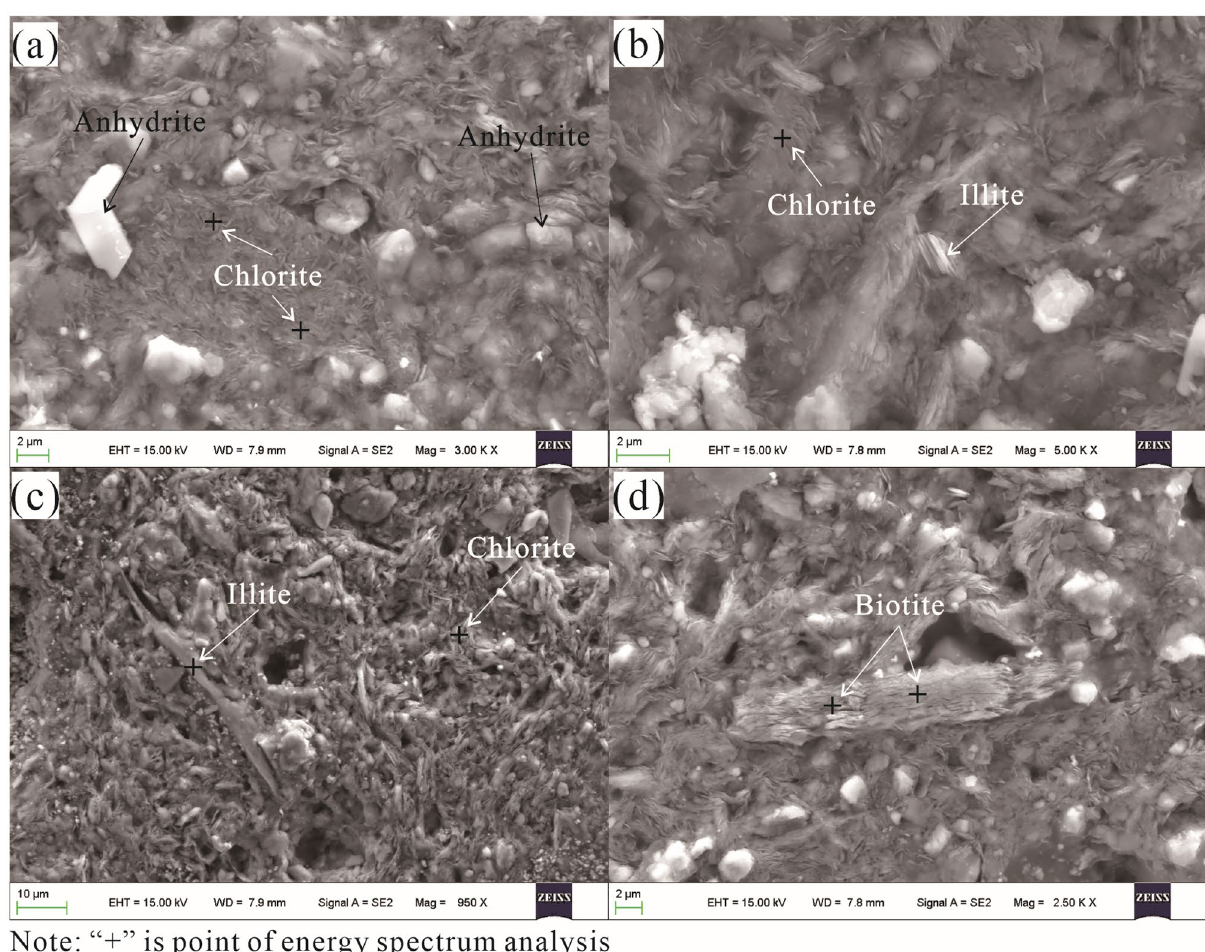
Figure 4. SEM images showing textural features of clay minerals. ( a ) Dominant chlorite and ( b ) flaky petaloid textures, ( c ) illite size and crystal structure and ( d ) close-up of biotite displaying the crystal size and relatively flat PAAS-normalized curve while that for granite was above that for the PAAS (indicating a higher content of REEs than that of PAAS) and with an apparent negative Eu anomaly; and (4) the pattern of the sample was also different from those of Jingdong and Mojiang basalts, whose PAAS-normalized patterns with inverted “L” shapes indicated lower LREEs and higher MREEs (Eu) than PAAS, and a similar HREE to PAAS. Discussion